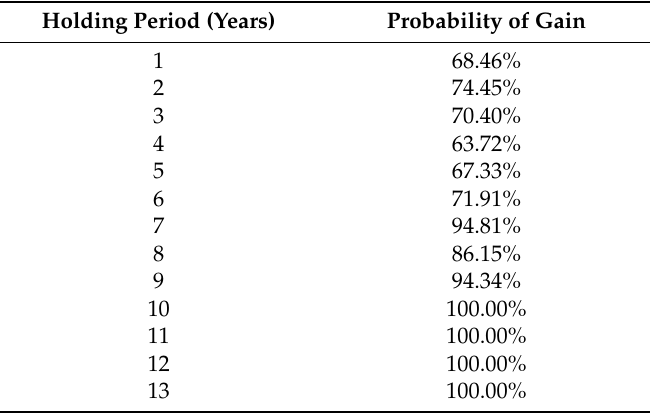
Table 1. BLDRS Developed Markets 100 ADR Index Fund (ADRD) Positive Gain to Principal